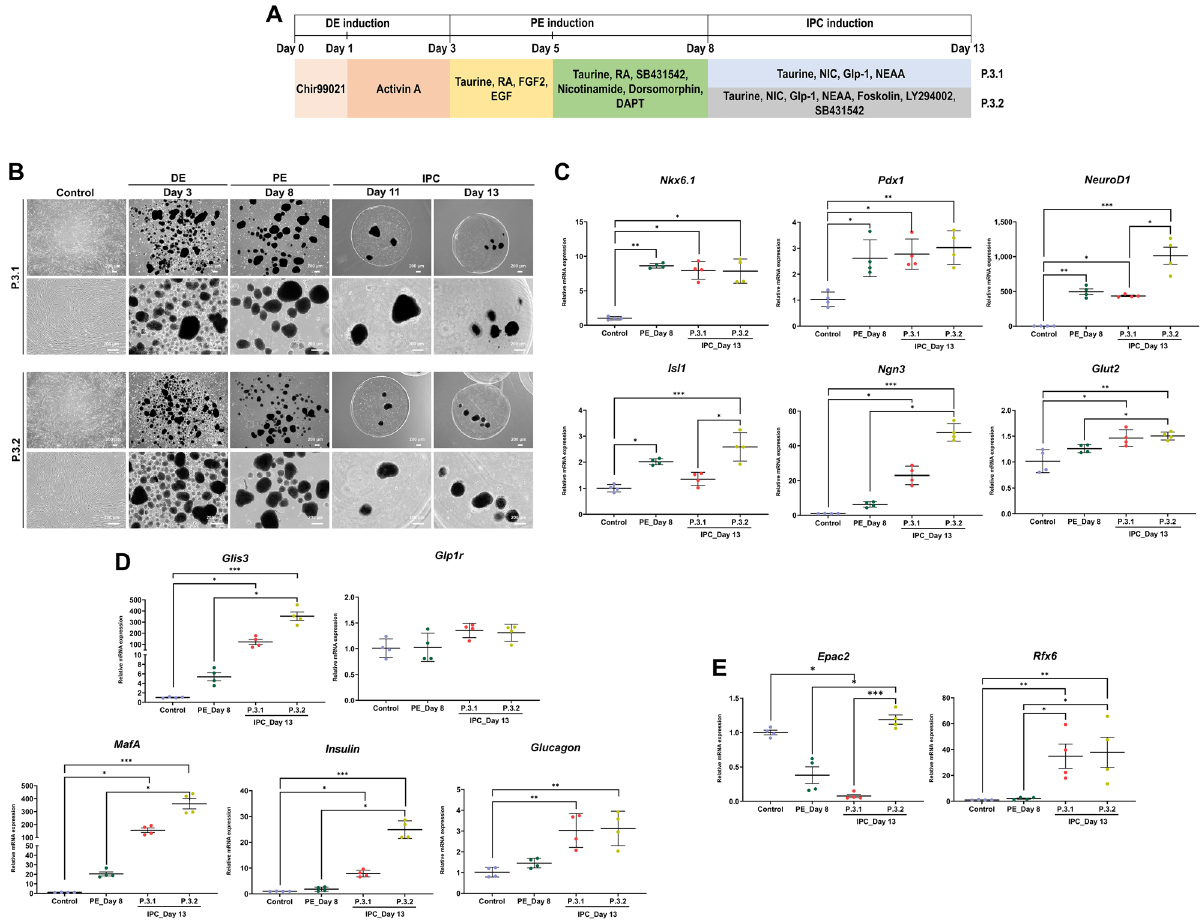
Figure 5. Generation of cAD-MSC-derived IPCs. The diagrams of two protocols used for the induction of cAD-MSC derived IPCs are shown in ( A ). Differentiation morphological appearances of cAD-MSCs toward IPCs were observed at day 8 and 13 post-induction ( B ). The expression of mRNA markers relating to PE precursors ( C ), mature endocrine progenitors ( D ), hormone release-related markers ( E ). Relative mRNA expression was normalized with the reference gene, and the undifferentiation control. Bars indicates the significant differences (*, p value < 0.05; **, p value < 0.01; ***, p value <